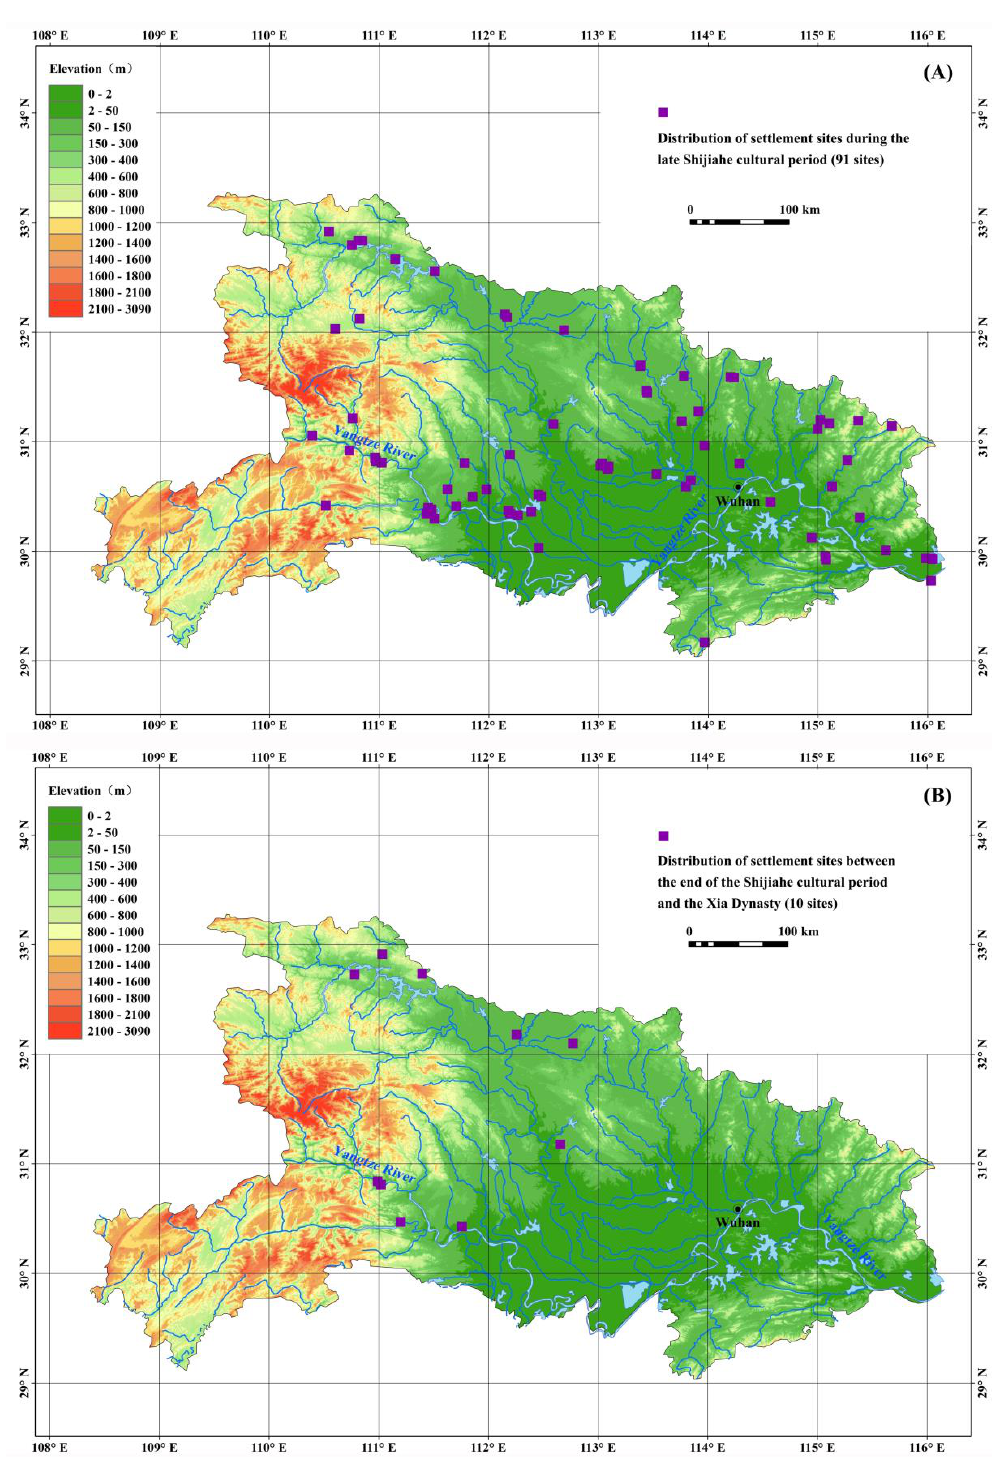
Figure 5. Distribution change of settlement sites before and after the 4.0 ka BP event in and around the Jianghan Plain area. ( A ) Distribution of settlement sites during the late Shijiahe cul-tural period (4.2–4.0 ka BP) in and around the Jianghan Plain area; and ( B ) distribution of set-tlement sites between the end of the Shijiahe cultural period and the Xia Dynasty (4.0–3.5 ka BP) in and around the Jianghan Plain